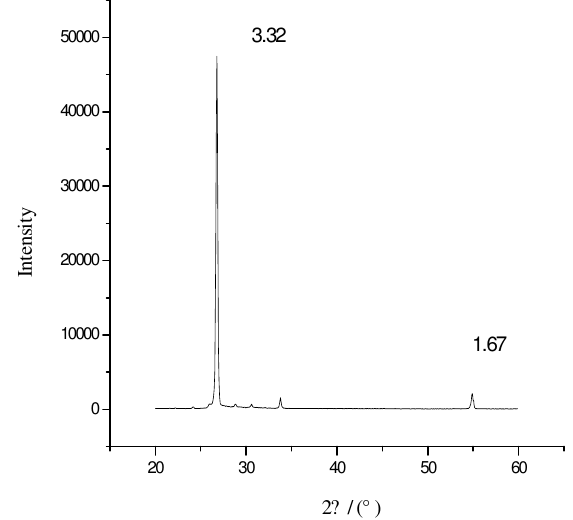
Figure 1. The X-ray diffraction spectrum of natural graphite